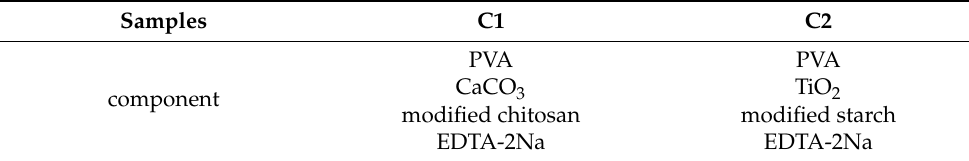
Table 1. Recipe for two aqueous polymeric